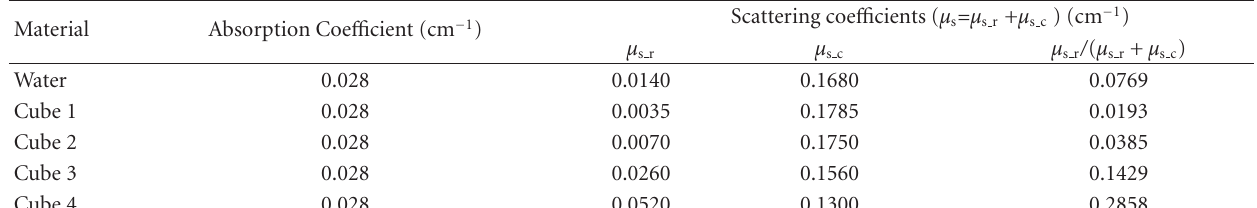
Table 1: X-ray absorption and scattering coe ffi cients at 50 KeV of the phantom components.